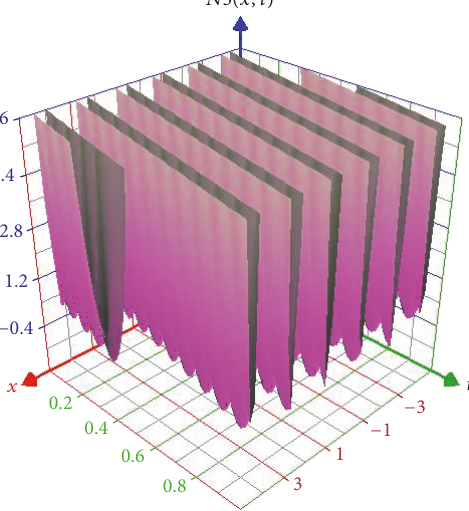
Figure 6: The solitary wave of 𝑁 3 (𝑥,𝑡) in (41) for −5 ≤ 𝑥 ≤ 5 , 0 ≤ 𝑡 ≤ 1